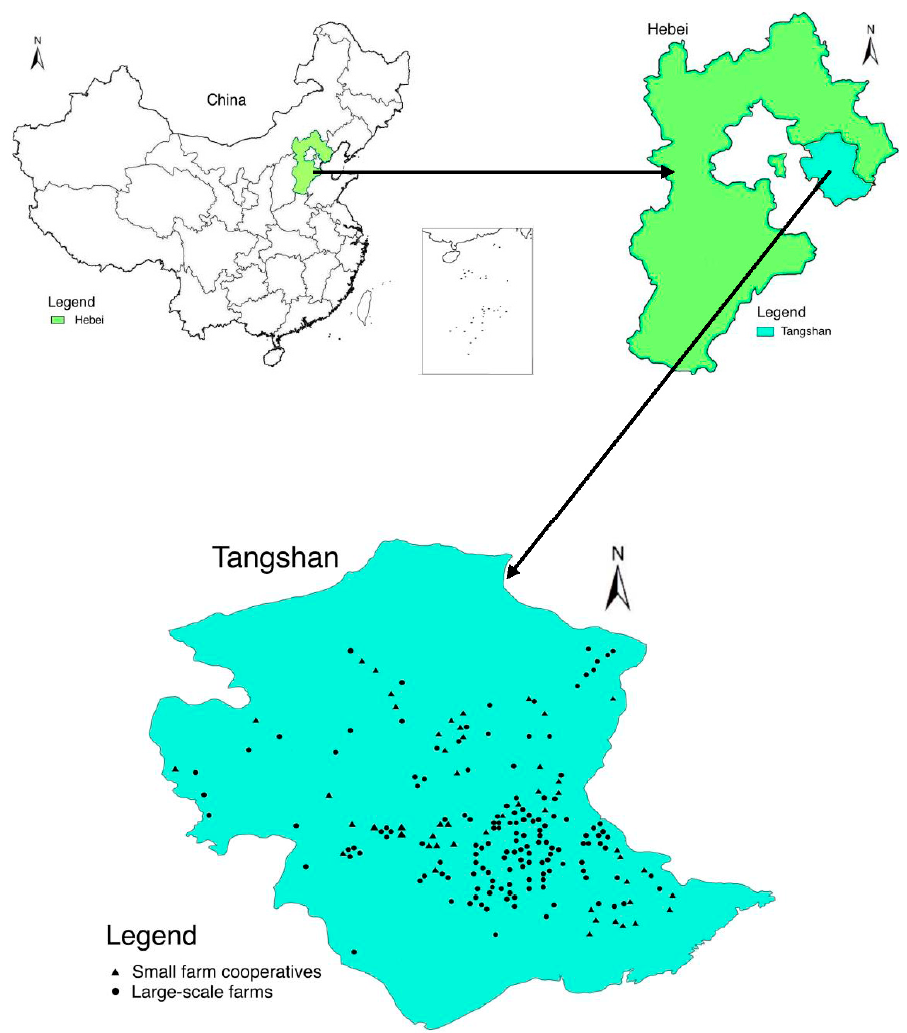
Figure 1. Sampling sites of raw milk from Tangshan, Hebei, China.